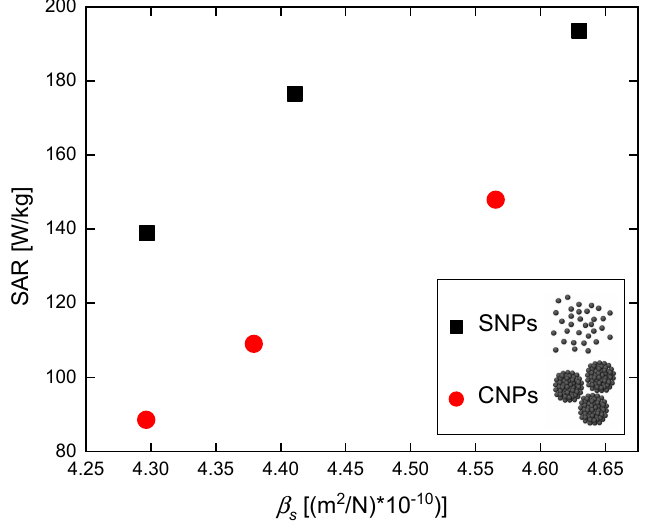
Figure 9. Specific absorption rate in a function of compressibility of tissue-mimicking phantom doped with SNPs or CNPs.